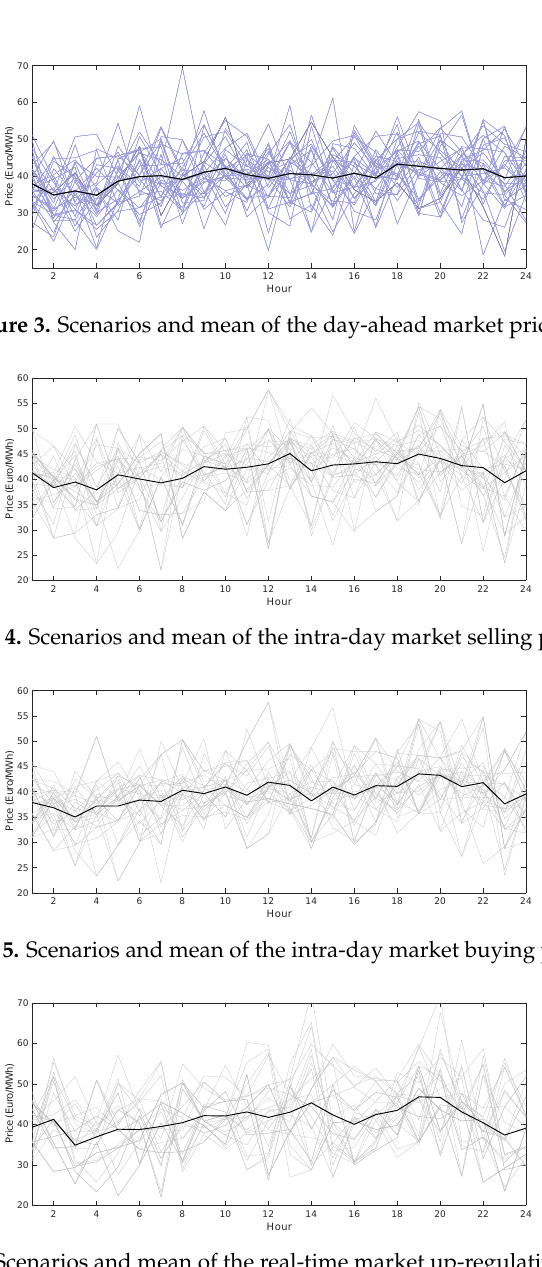
Figure 6. Scenarios and mean of the real-time market up-regulating prices.